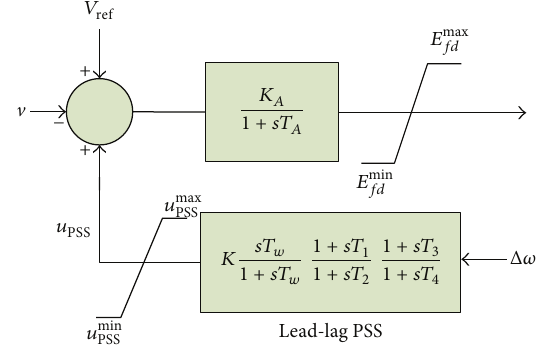
Figure 2: IEEE type ST1 excitation system with power system stabil-